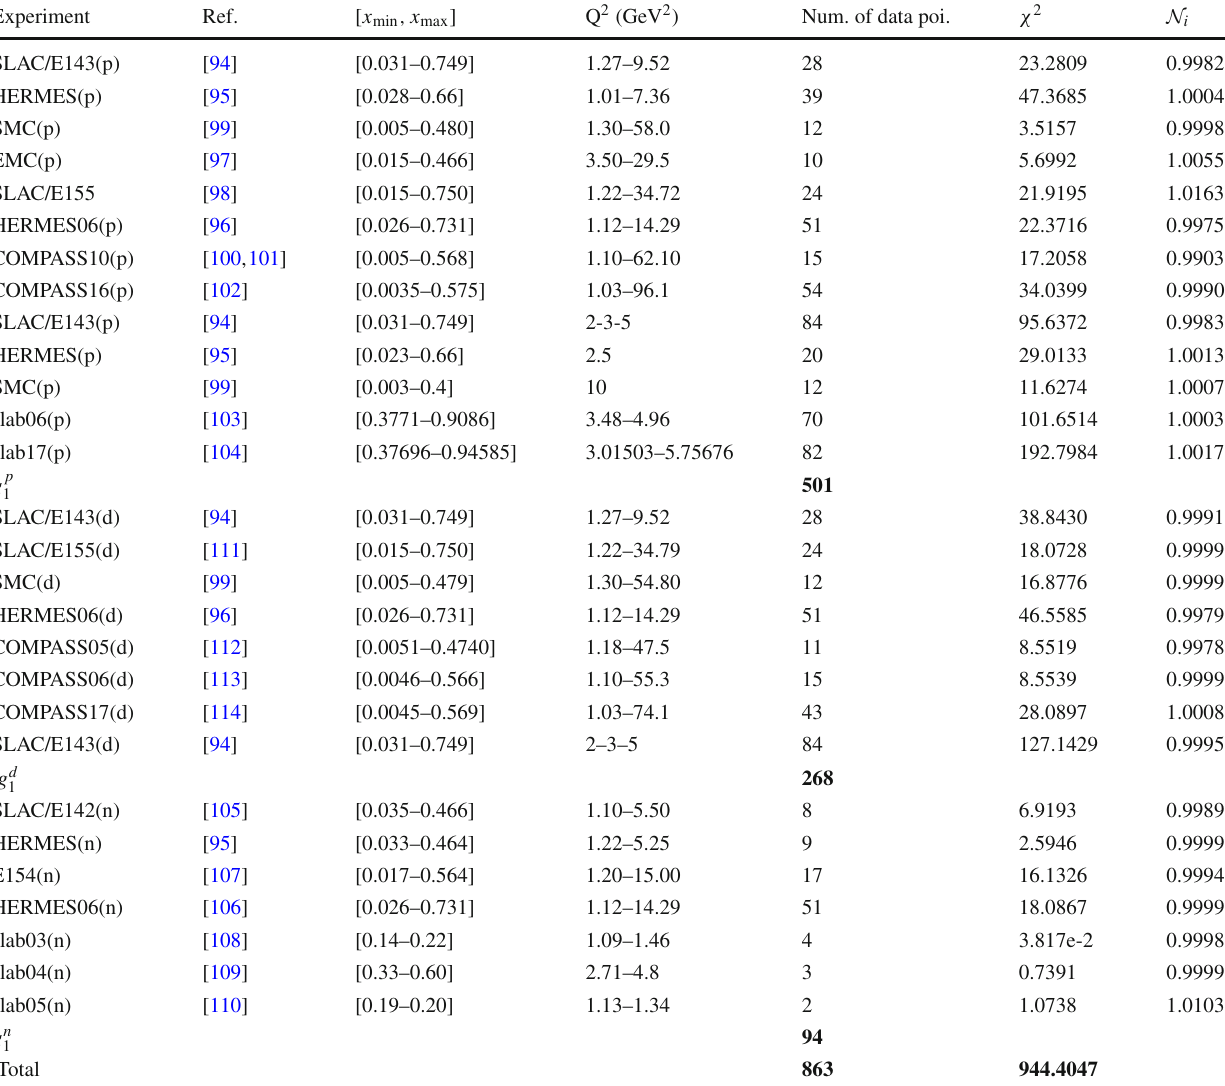
Table 1 Summary of published polarized DIS experimental data points with measured x and Q 2 ranges and the number of data points Experiment